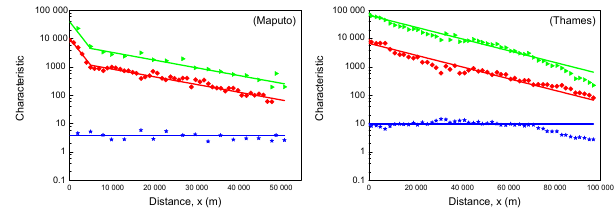
Figure 3. Semi-logarithmic presentation of estuary geometry, com- paring simulated (lines) to observations (symbols), including cross- sectional area (green), width (red) and depth